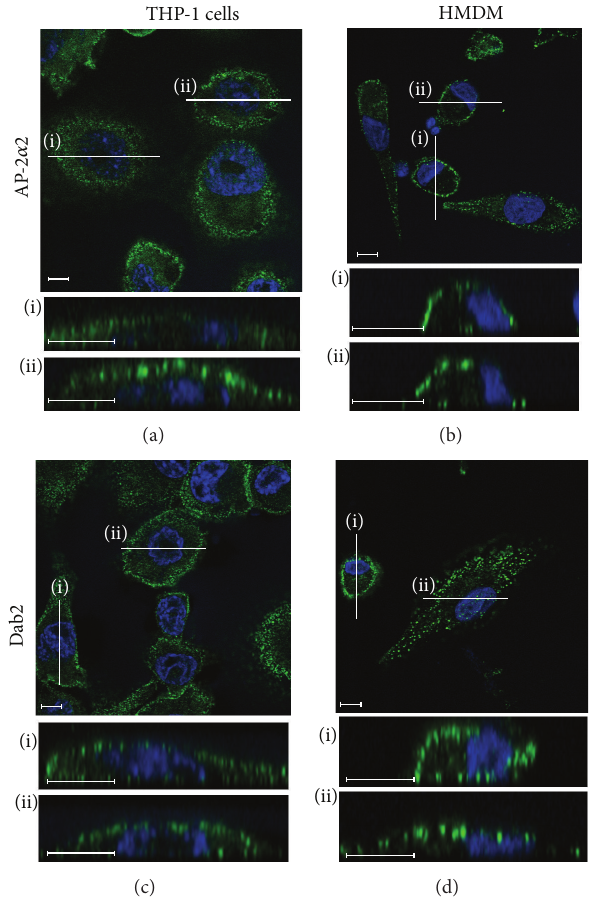
Figure 4: Subcellular location of AP-2, Dab2, and Myo6 in THP- 1 macrophages and HMDM. THP-1 macrophages (a, c) or HMDM (b, d) were fixed and probed with IgG polyclonal mouse anti-AP-2 𝛼 2 followed by FITC-conjugated anti-mouse antibody (green) (a, b) or IgG polyclonal rabbit anti-Dab2 followed by anti-rabbit antibody conjugated to Alexa488 (green) (c, d); all cells were counterstained with DAPI (blue) to highlight cell nuclei. Z-stacked images were taken using a Leica SP5 CLS microscope. The main panels show a single xy section through the cells. Below each, xz or yz vertical sections (i and ii) through individual cells are shown. Lines on the mainpanelsshowfromwherethesecross-sectionsaretaken.Typical images taken from a minimum of three separate experiments with THP-1 cells, or HMDM from three individual donors, are shown. Scale bars = 10 𝜇